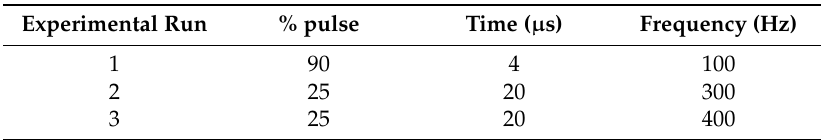
Table 1. Experimental conditions of the High-Intensity Pulsed Electric Field (HiPEF) treatment applied to concentrated infusions of Buddleja scordioides